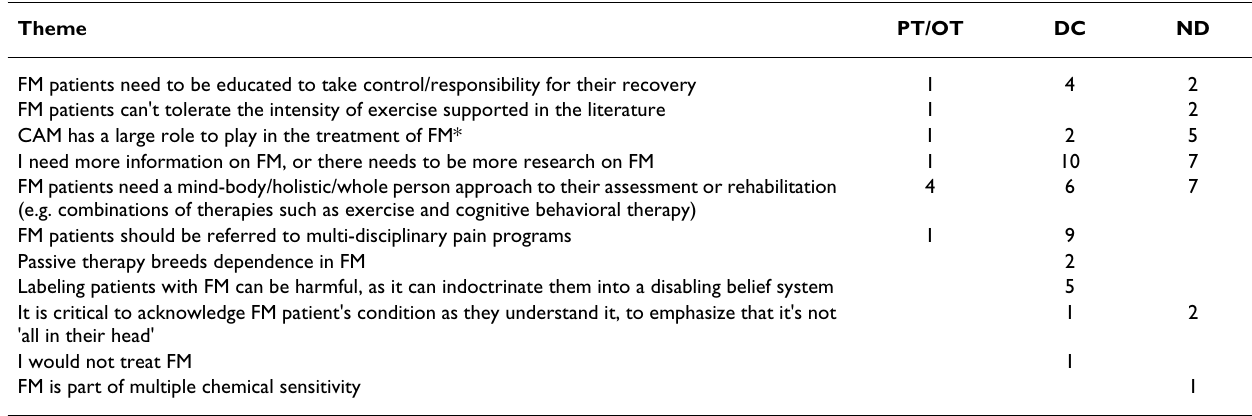
Number of comments by student